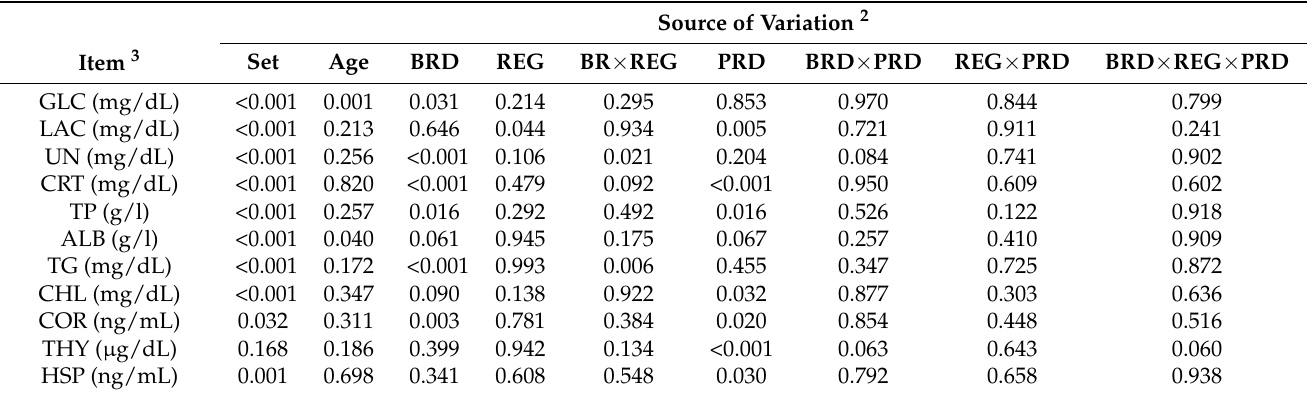
Table 4. p values for effects of breed, region, and period with different heat load indexes on serum concentrations of glucose, lactate, urea nitrogen, creatinine, total protein, albumin, triglycerides, cholesterol, cortisol, thyroxine, and heat shock protein 70 in hair sheep 1 . Source of Variation